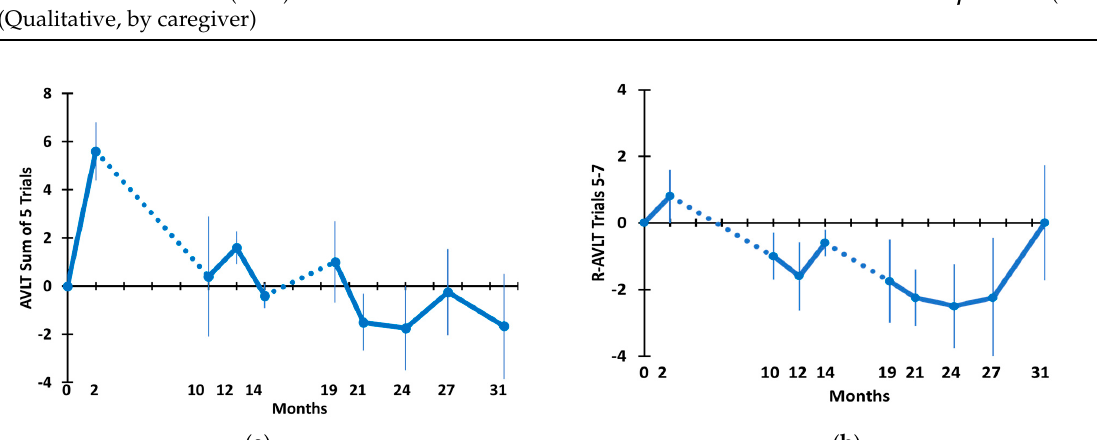
Figure 4. ( a ) Rey Audio Verbal Learning Test sum of five trials and ( b ) Rey AVLT retroactive interference through 31 months. Dotted lines indicate the 8M and 5M periods of no treatment.